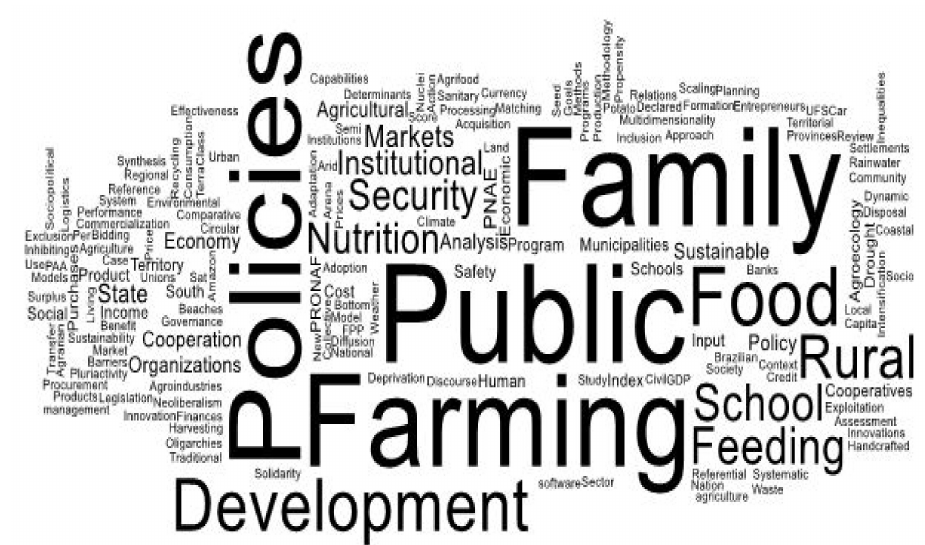
Figure 5. Word cloud of keywords. Source: research data (2021).